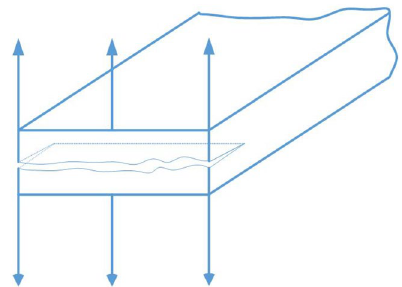
Figure 13 I opening-mode cracks in specimens